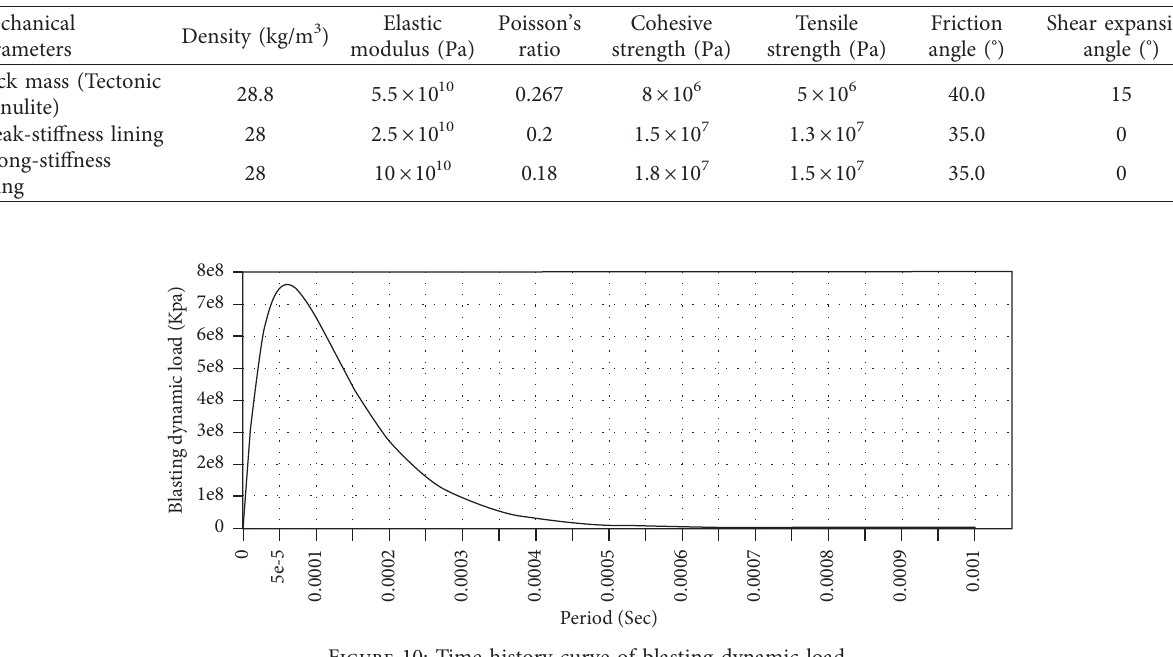
Table 5: Mechanical parameters of rock mass and lining.